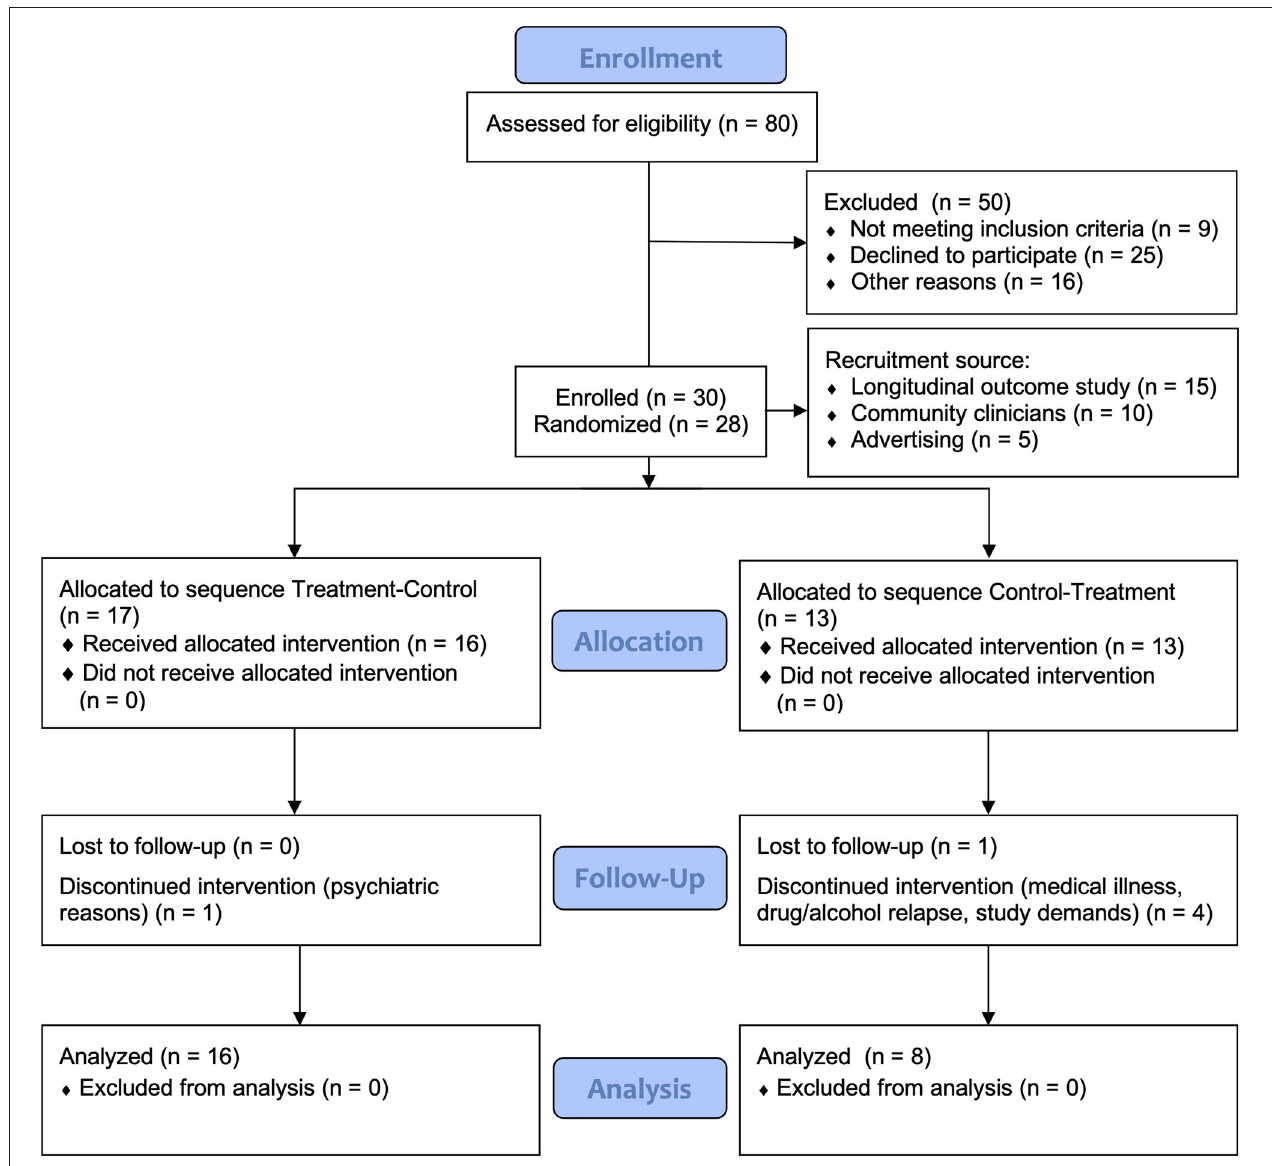
FIGURE 1 | CONSORT flow diagram of recruitment and participant retention. The first two participants were not randomized as they were part of an initial two-case pilot